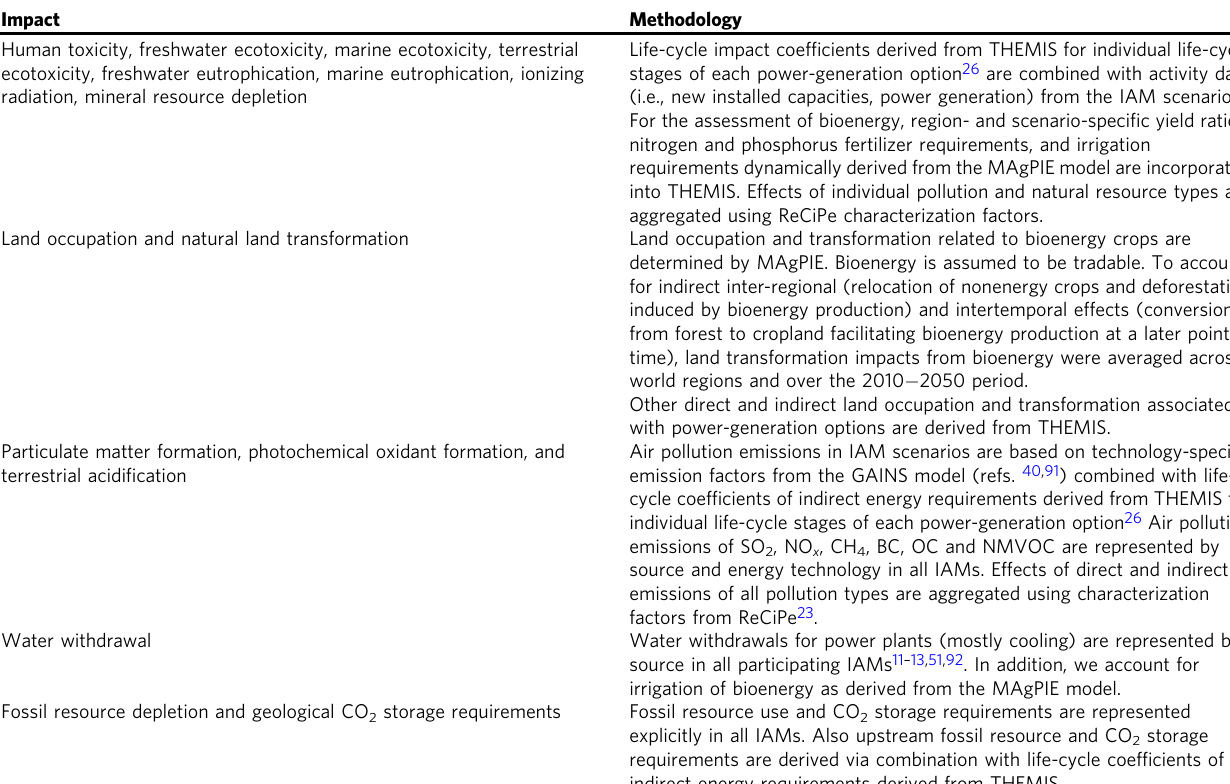
Table 2 Overview of methodologies for speci fi c environmental